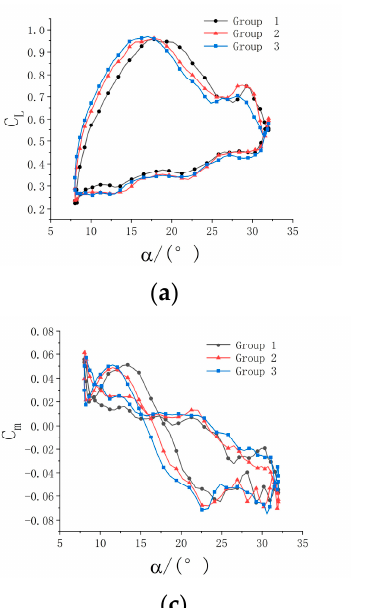
Table 5. Static test conditions.